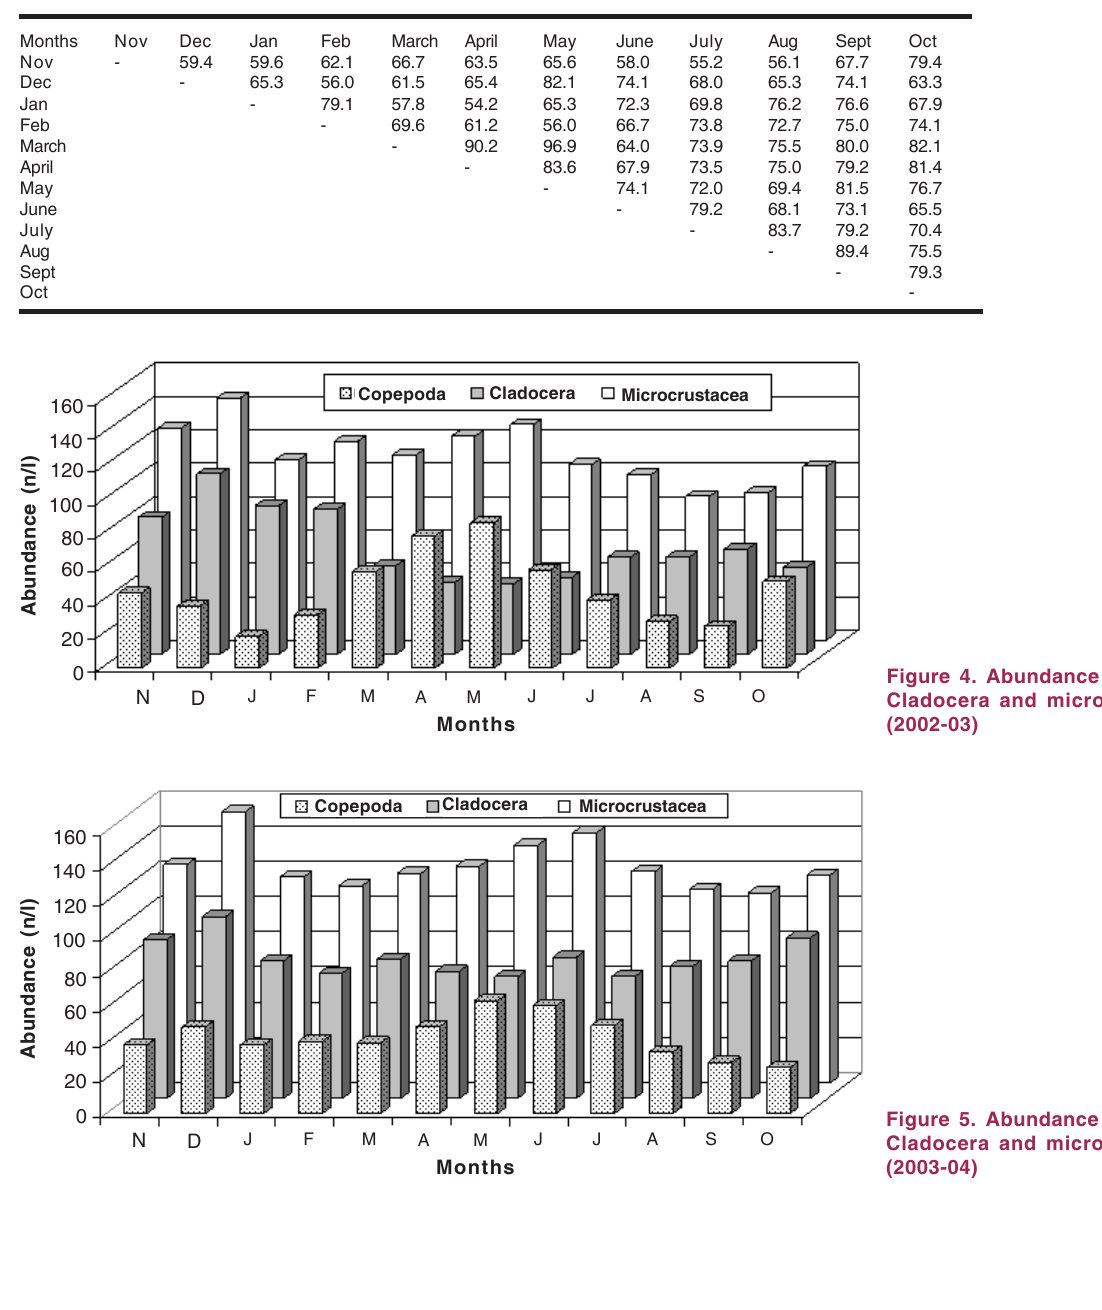
Figure 5. Abundance of Copepoda, Cladocera and